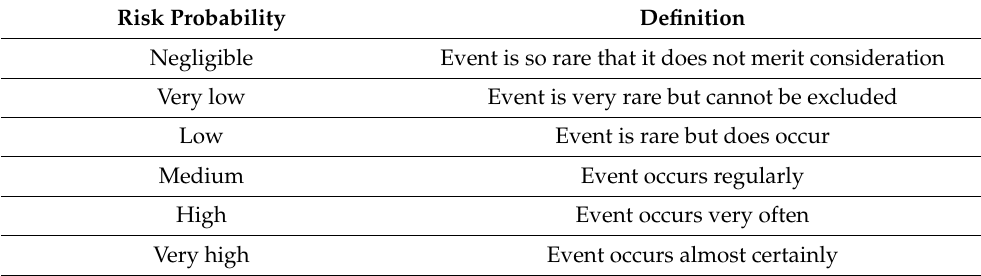
Table 1. Definitions of qualitative probability categories